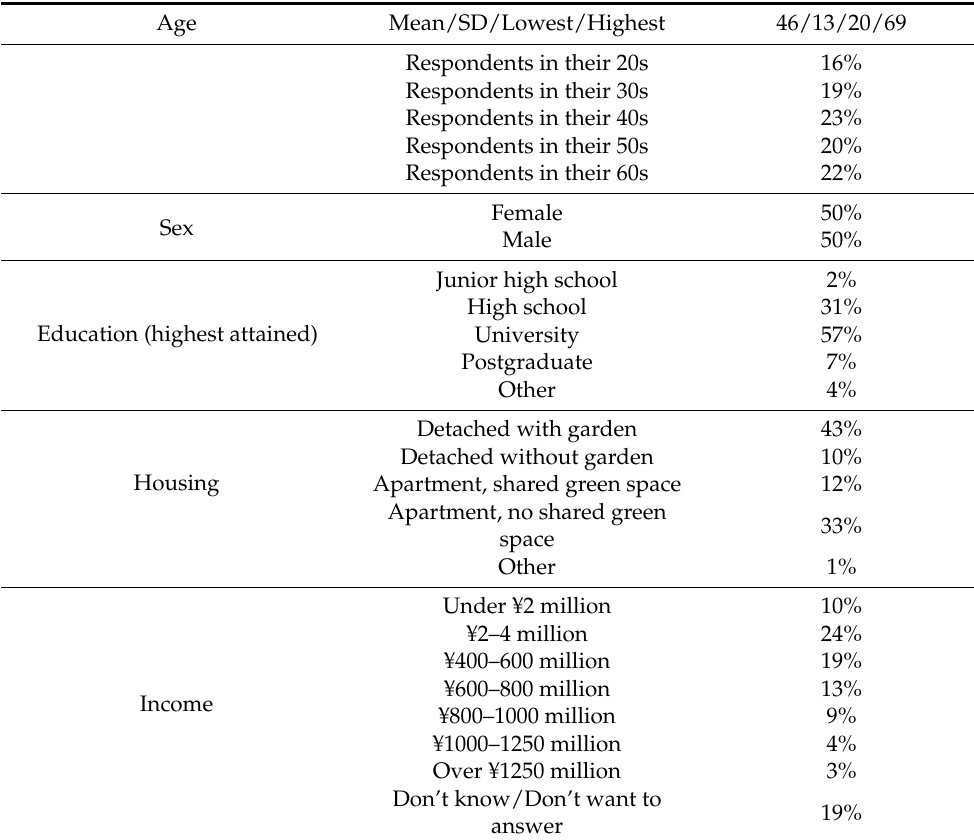
Table 2. Demographic characteristics of respondents ( n =